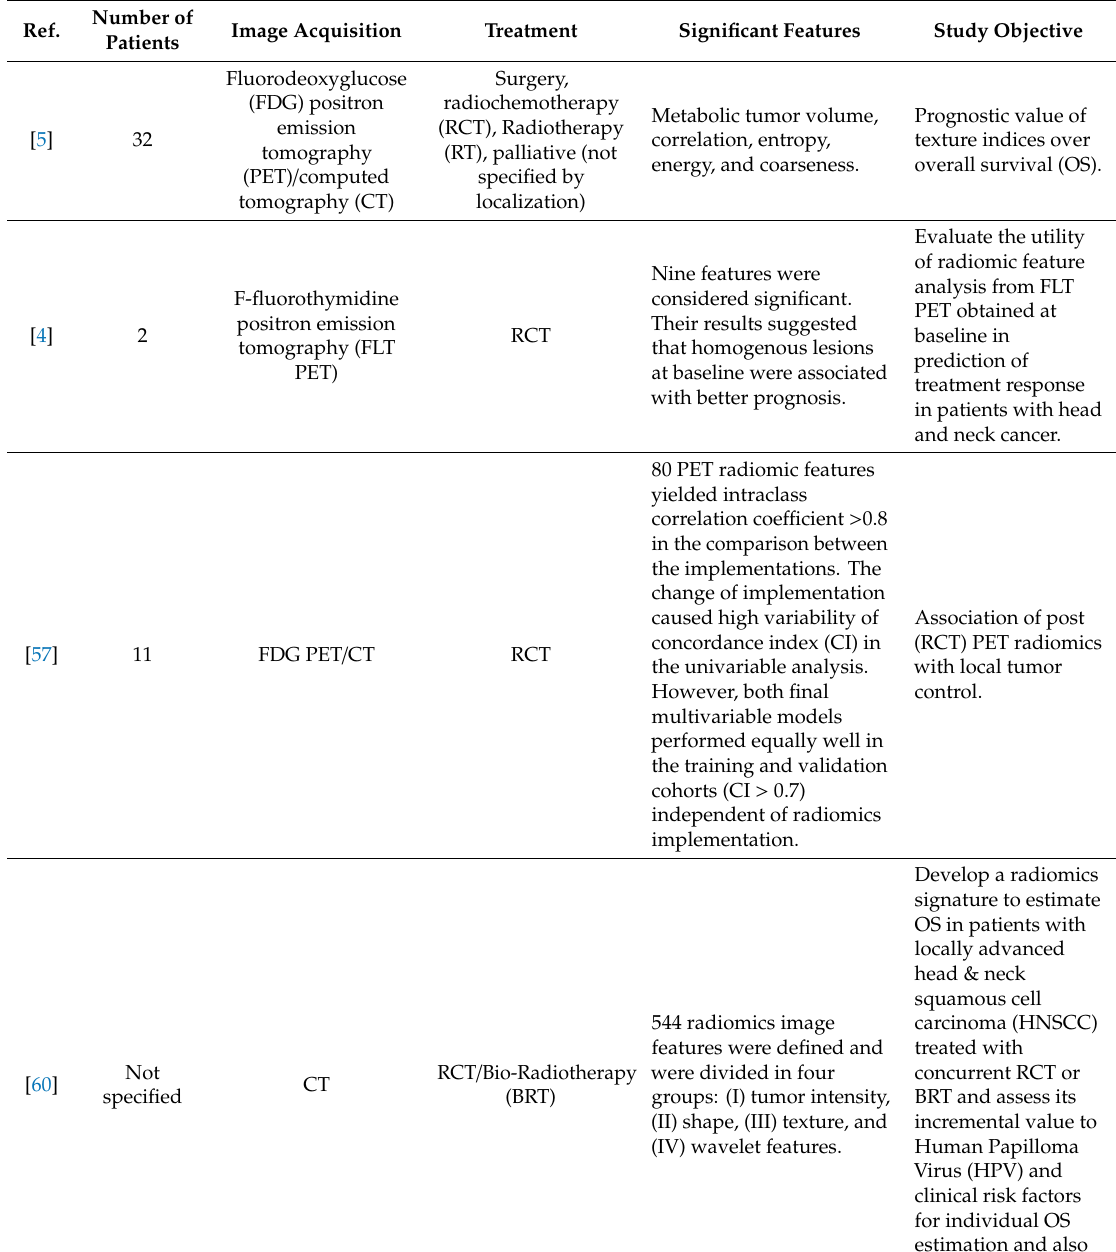
Table 1. Studies about radiomics and textural analysis including larynx cancer patients.